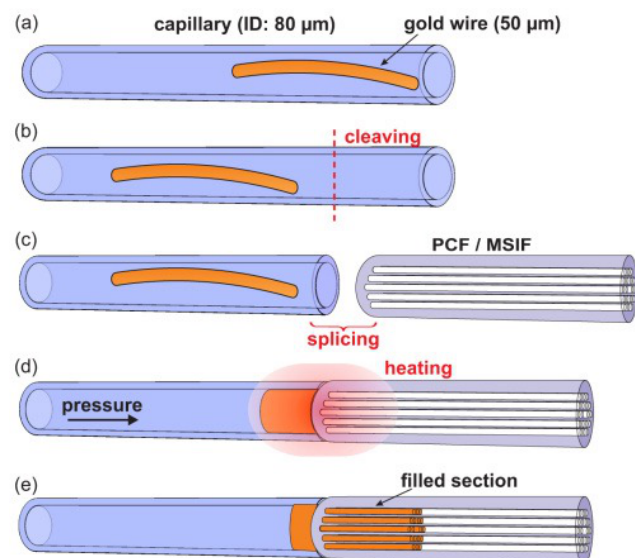
Figure 5. The spliced-fiber pressure-filling technique. ( a ) a gold wire is inserted into a silica capillary; ( b ) the wire is pushed into the capillary using a tungsten wire and the capillary end cleaved off; ( c ) capillary with wire is spliced to a silica fiber with hollow channels; ( d ) the spliced section is heated to the melting point of gold and high pressure argon gas is applied; ( e ) the filled structure. Reprinted with permission from [56].